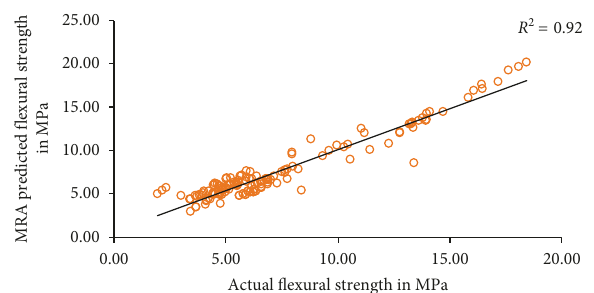
Figure 5: Actual vs. MRA predicted value for flexural strength.